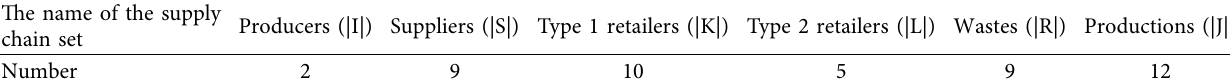
Table 1: Numerical information on the number of supply chain sets under